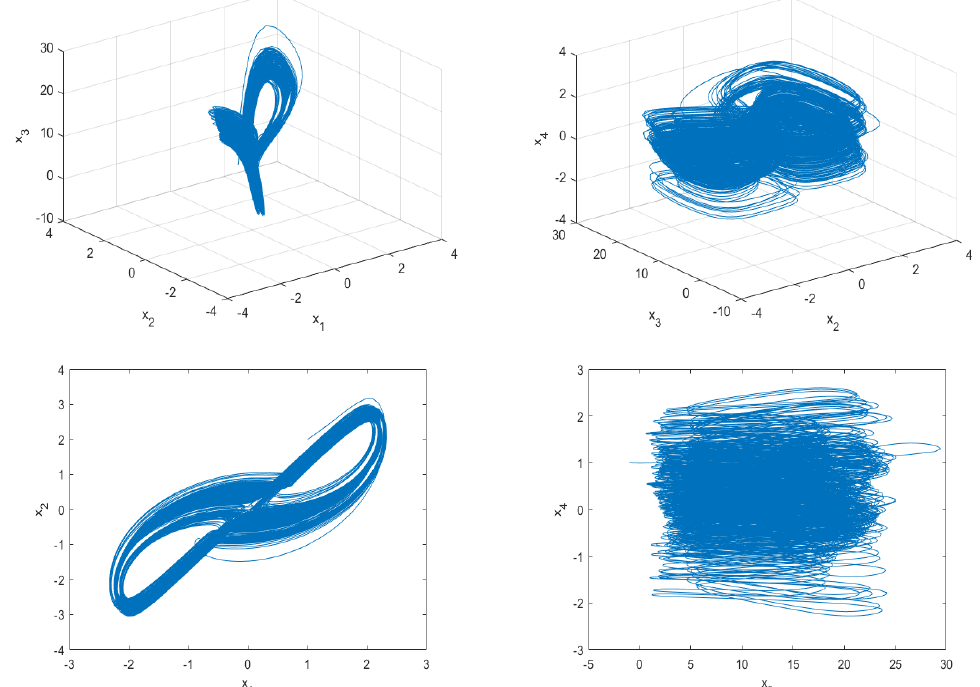
Figure 4. Phase portraits of system (1) with a = 10, b = 9, c = 8/3, d = 0.1.